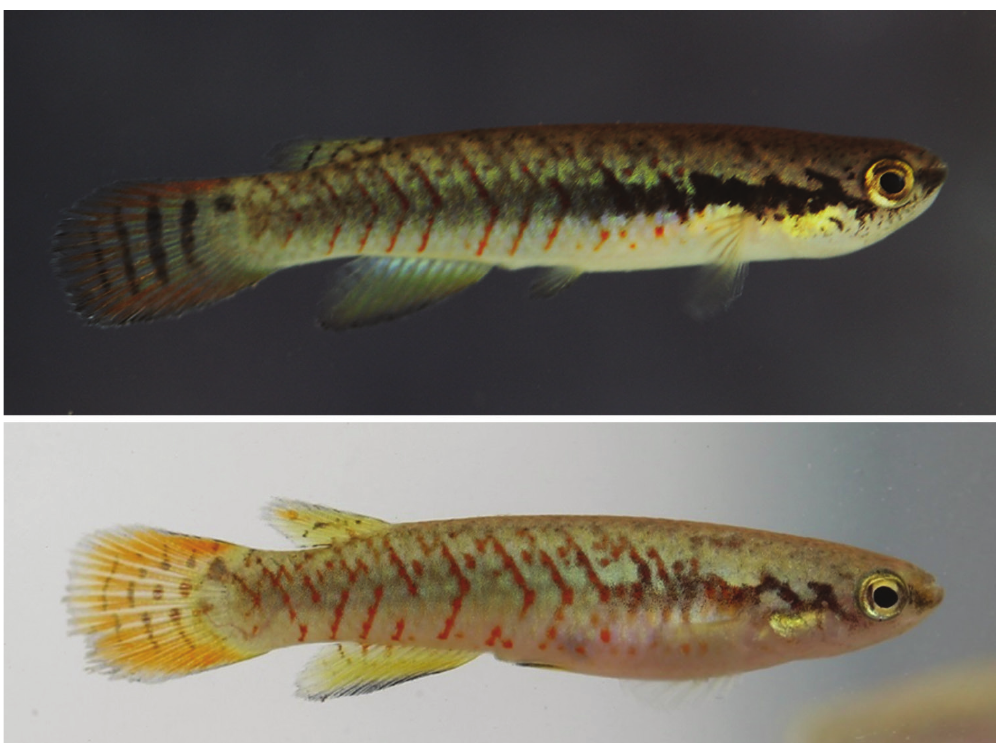
Figure 6. Female paratypes of M. ivinhemensis sp. n., MCP 53153, Nova Andradina municipality, Rio Ivinhema, Mato Grosso do Sul state.